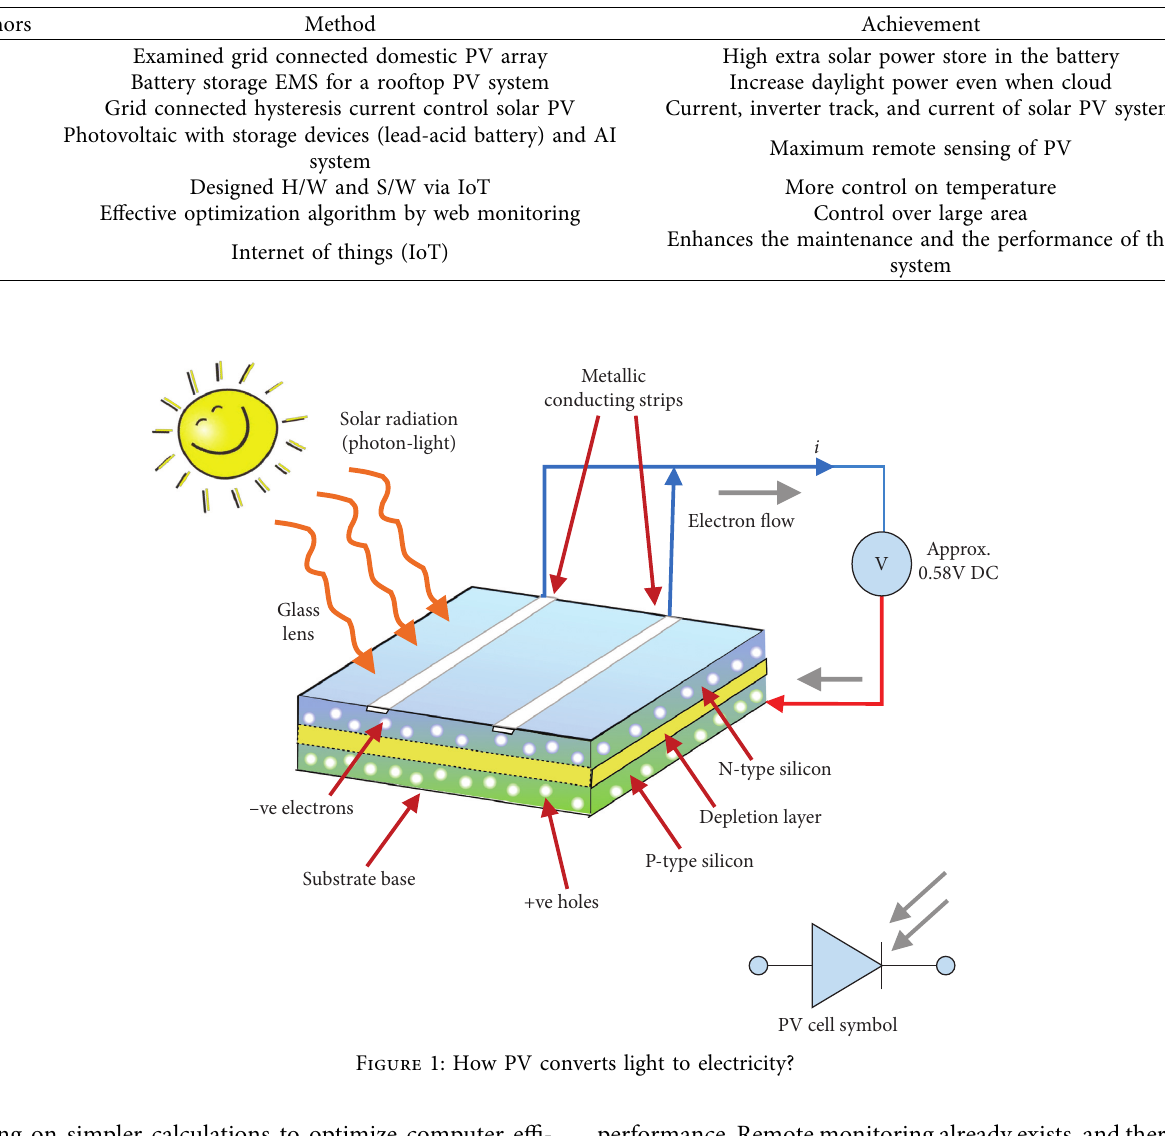
Table 1: Most important studies in literature which considered remote monitoring of solar